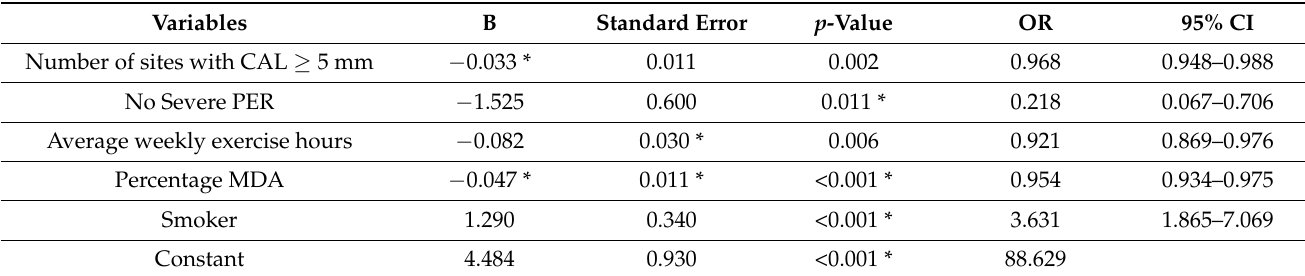
Table 7. Results of the binary logistic regression analysis to estimate the association between the different variables and those who suffer from MI.